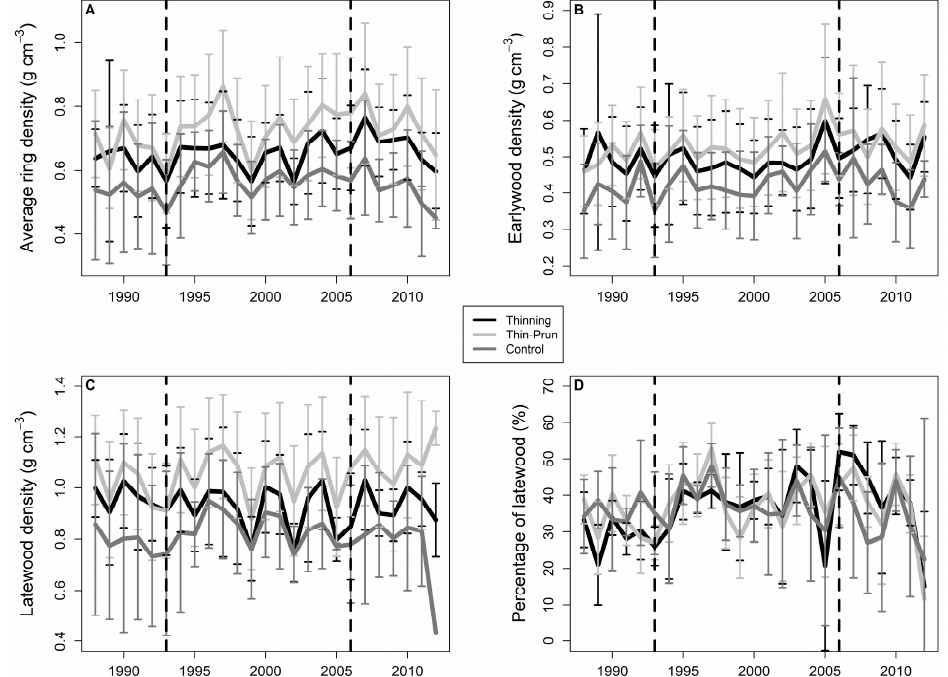
Figure 3. Mean trends ± standard deviation of average ring density ( A ), earlywood density ( B ), latewood density ( C ), and percentage of latewood ( D ) for the treatments in Pinus nigra salzmannii trial. Vertical dashed lines indicate thinning treatment dates (1993 and 2006).